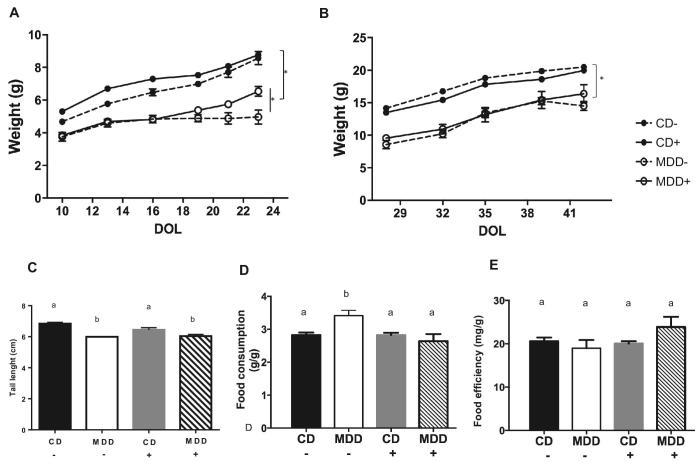
Prenatal and postnatal exposure to methyl donor deficiency diet leads to growth faltering in suckling and weaned mice. (A) Pups of dams fed MDD diets with or without antibiotics (n = 7 and n = 5, respectively) exhibited significant failure to thrive compared with pups of dams fed CD with or without antibiotics (n = 9 and n = 11, respectively). (B) Growth faltering persisted, without catch-up growth, until 7 wk of age. (C) Prenatal exposure to methyl donor deficiency with antibiotics impaired linear growth as measured by tail length. Weight differences were not explained by variation in (D) food consumption or (E) feed efficiency. Values are means ± SEMs. Means without a common letter differ, P < 0.05. CD+/−, control diet with/without succinylsulfathiazole; DOL, day of life; MDD+/−, methyl donor–deficient diet with/without succinylsulfathiazole. Asterisk indicates (*) P < 0.05 for group differences by repeated measures ANOVA with Bonferroni correction for multiple comparisons.